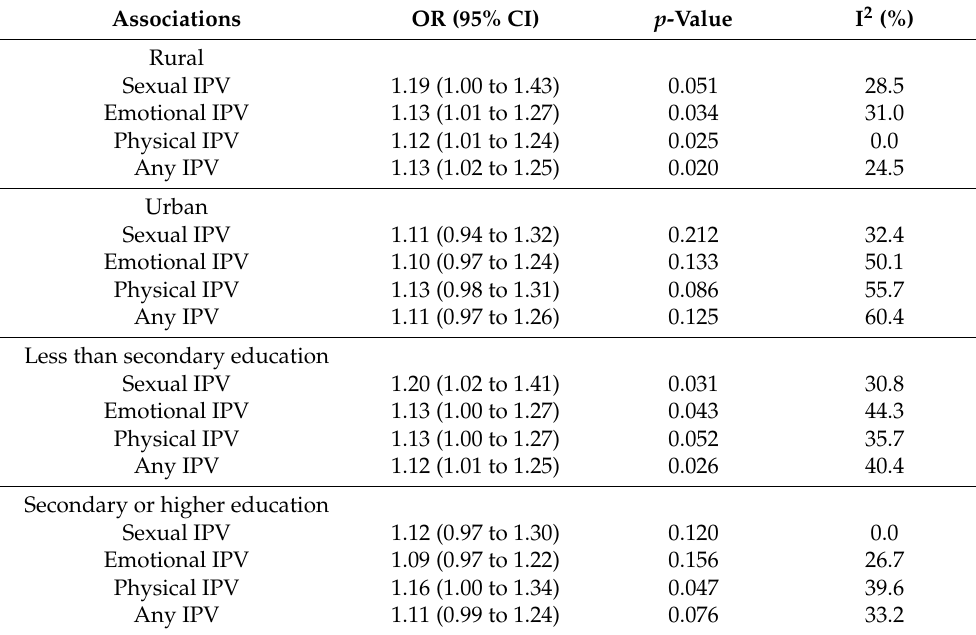
Table 5. Stratified associations of inadequate living conditions with intimate partner